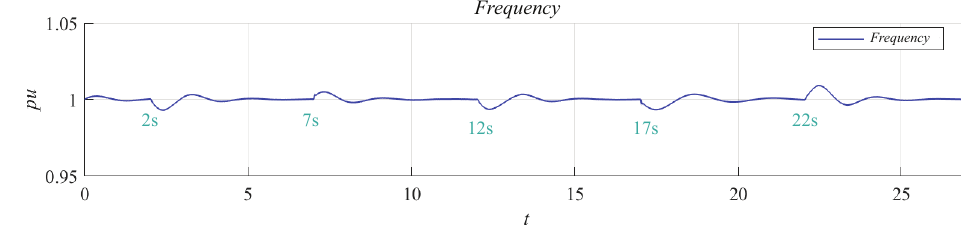
Figure 14. System frequency in per unit for case study 1.